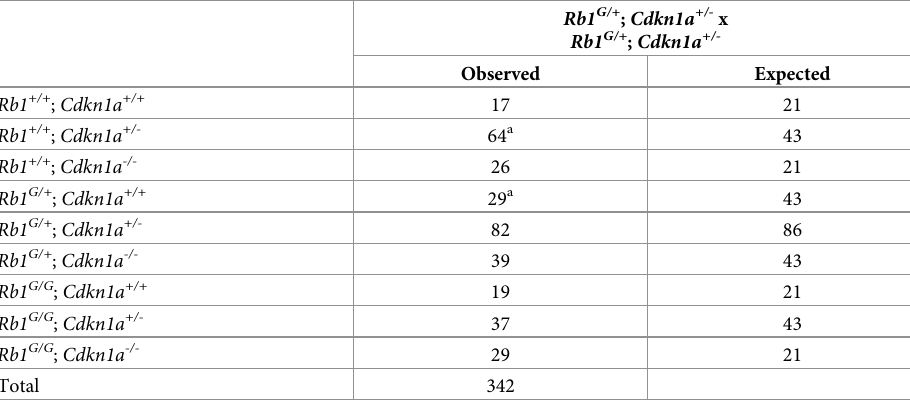
Table 2. Frequency of generating Rb1 G ; Cdkn1a -/- compound mutant mice. Rb1 G/+ ; Cdkn1a +/- x Rb1 G/+ ; Cdkn1a +/- Observed Expected Rb1 +/+ ; Cdkn1a +/+ 17 21 Rb1 +/+ ; Cdkn1a +/- 64 a 43 Rb1 +/+ ; Cdkn1a -/- 26 21 Rb1 G/+ ; Cdkn1a +/+ 29 a 43 Rb1 G/+ ; Cdkn1a +/- 82 86 Rb1 G/+ ; Cdkn1a -/- 39 43 Rb1 G/G ; Cdkn1a +/+ 19 21 Rb1 G/G ; Cdkn1a +/- 37 43 Rb1 G/G ; Cdkn1a -/- 29 21 Total 342 The indicated genotypes of mice were crossed and all resulting progeny were genotyped. The number of live animals oberved at two weeks of age is indicated for each genotype and the expected number based on Mendelian inheritance is indicated. a denotes significance as determined by chi-squared